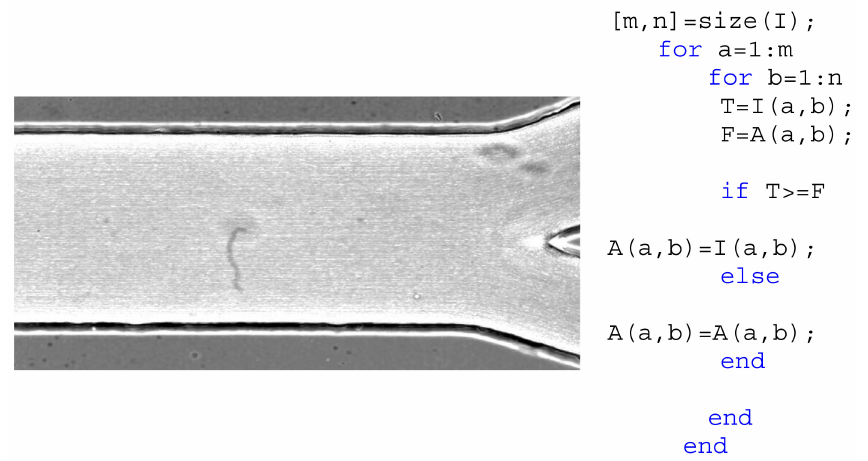
Figure 15. Image with the maximum intensity evaluation. As a final step, the image was converted into a binary image, the regions of interest were selected and the upper CFL trajectories were automatically measured. Figure 16 shows the image processing result for the developed method.